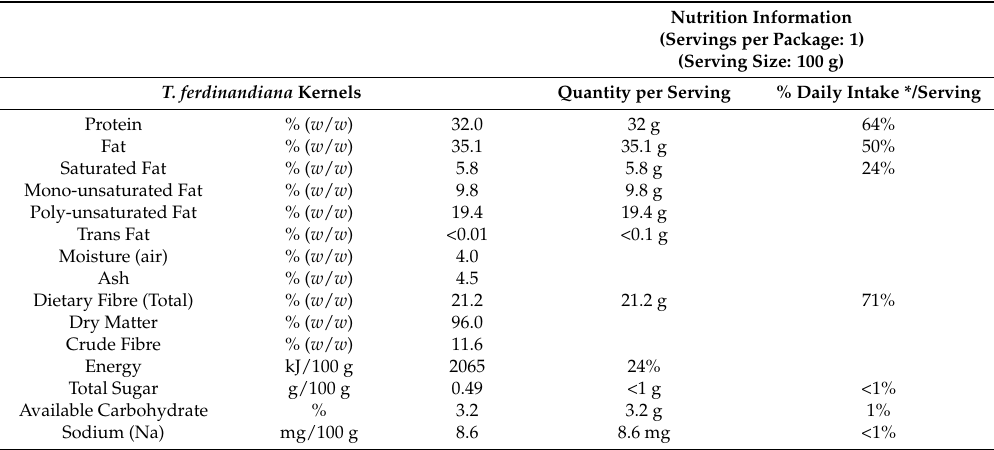
Table 1. Proximate composition of Terminalia ferdinandiana kernels.